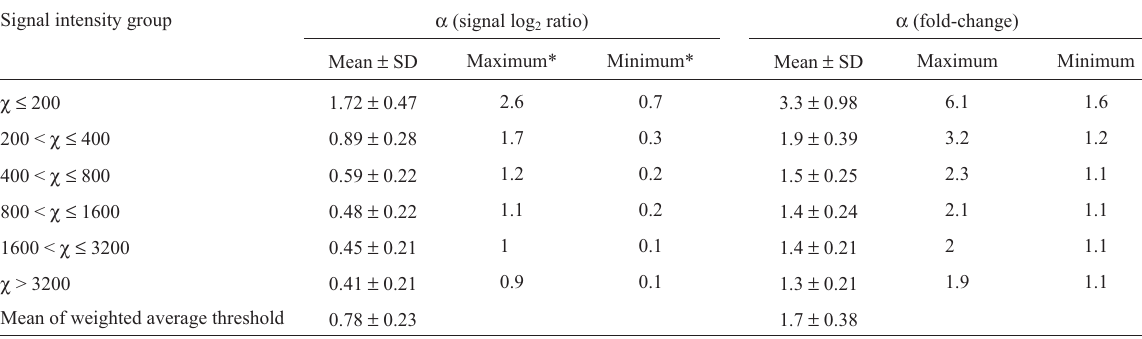
Mean of weighted average threshold 0.78 ± 0.23 *Maximum/minimum threshold at that signal intensity in a group of 65 comparisons.